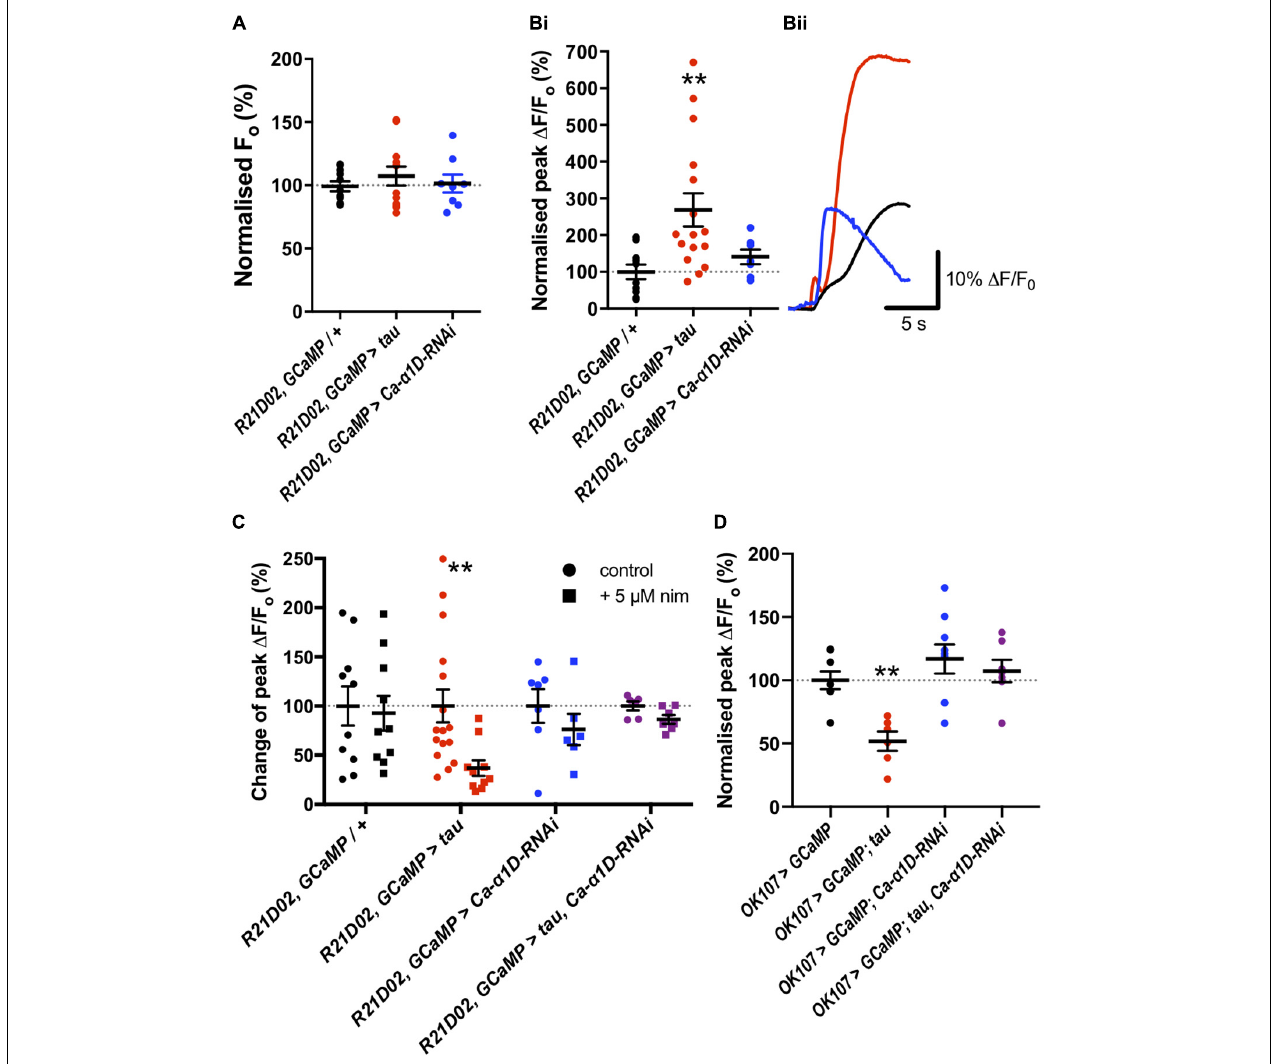
FIGURE 2 | Tau expression elevated nimodipine-sensitive Ca 2 + channels in mushroom body (MB) and M4/6 neurons. (A) Basal Ca 2 + levels were no different between control neurons and those expressing tau or Ca- α 1D-RNAi . (Bi) However, the peak magnitude of Ca 2 + transients were greater in the tau-expressing neurons than in control or Ca- α 1D-RNAi -expressing neurons. (Bii) GCaMP6f relative fluorescence changes over time traces of M4/6 neurons in response to 100 mM KCl for control (black trace), tau (red trace) and Ca- α 1D-RNAi (blue trace). (C) Ca 2 + transients in control and Ca- α 1D-RNAi -expressing neurons were not sensitive to the L-type Ca 2 + channel blocker nimodipine (black and blue symbols, respectively). Driving tau expression in M4/6 neurons conferred sensitivity of Ca 2 + transients to nimodipine (red symbols). The effect of tau on Ca 2 + transient nimodipine sensitivity was ablated by co-expression of tau and Ca- α 1D-RNAi in these neurons (purple symbols). Control for each genotype normalized to 100%. (D) Tau expression in the MB reduced peak fluorescence following a high KCl challenge; an effect reversed by co-expression of Ca- α 1D-RNAi . Data analyzed with one-way ANOVA with Dunnett’s post hoc tests panels (A,D) , with Kruskal–Wallis test with Dunn’s post hoc tests panel (B) or with two-way ANOVA with Sidak’s post hoc tests panel (C) . ∗ / # p < 0.05, ∗∗ / ## p < 0.01, and ∗∗∗ / ### p < 0.001. Note that data for OK107 > GCaMP and OK107 > GCaMP, tau are reproduced from Higham et al.